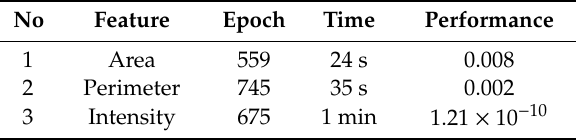
Table 6. Training performance of the neural network.